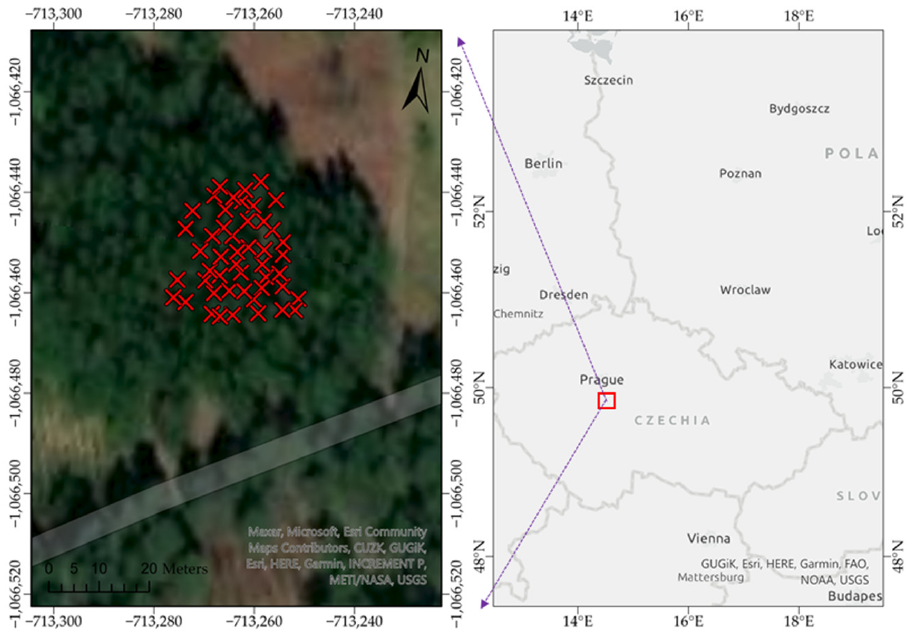
Figure 1. Map of Czechia with the geographic location of the study area.